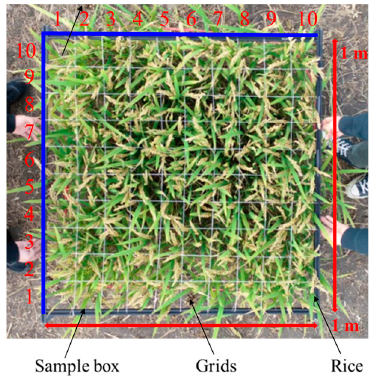
Figure 3. Gridded sampling frame to measure the plant height distribution.